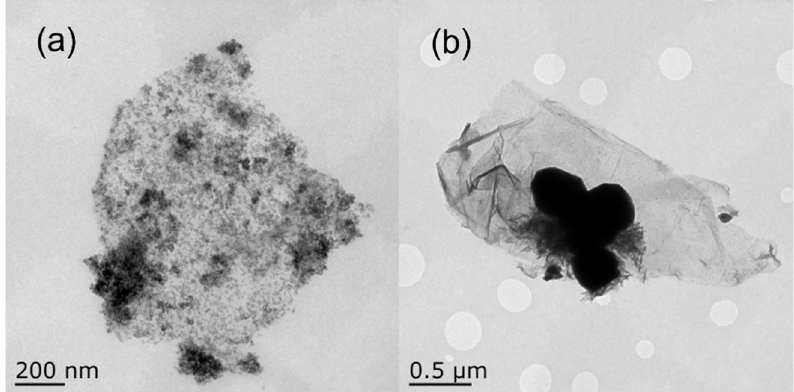
Figure 13. TEM images for ( a ) a holding time of 1 h and ( b ) 10 mL of deionized water.